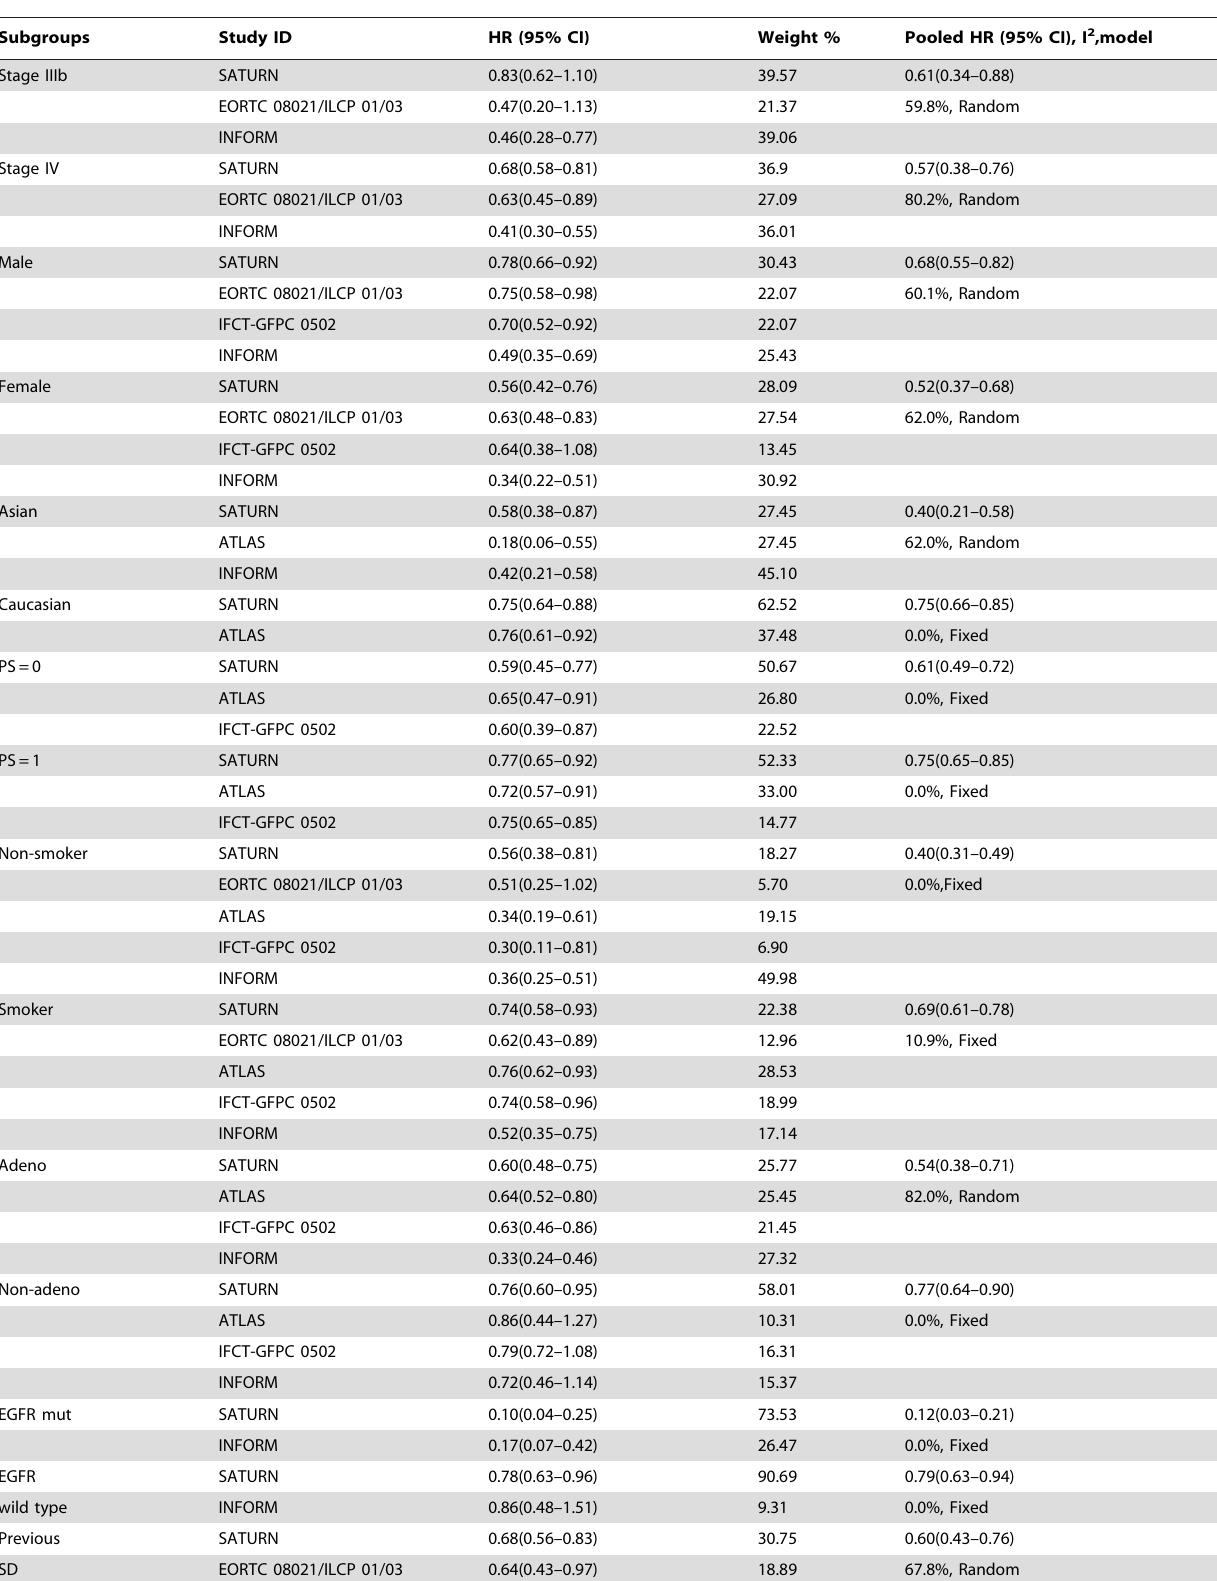
Table 2. Summary of meta-analysis of progression free survival (PFS) in